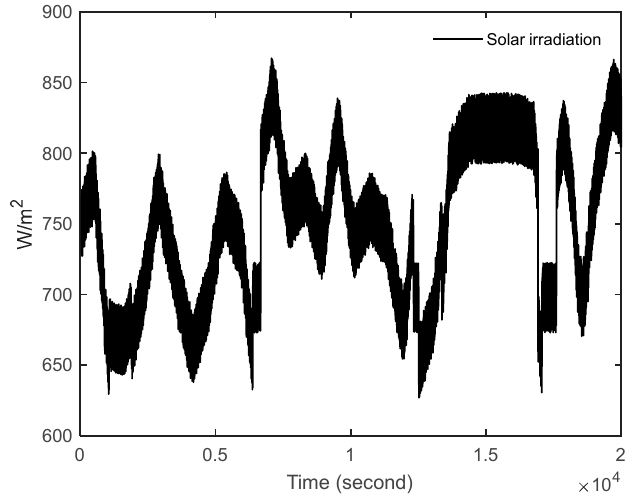
Figure 14. Profile of the simulated solar irradiation disturbance.